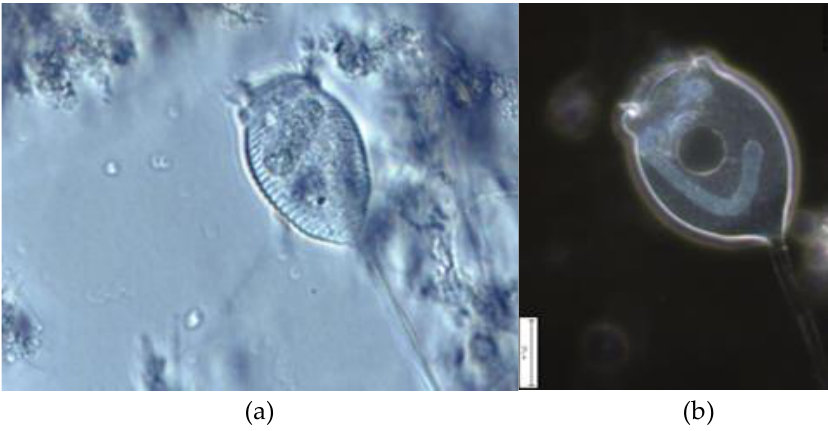
Figure 2. Litonotus lamella in transmitted light after retardation: ( a ) ventral rows of cilia; ( b ) macronucleus.